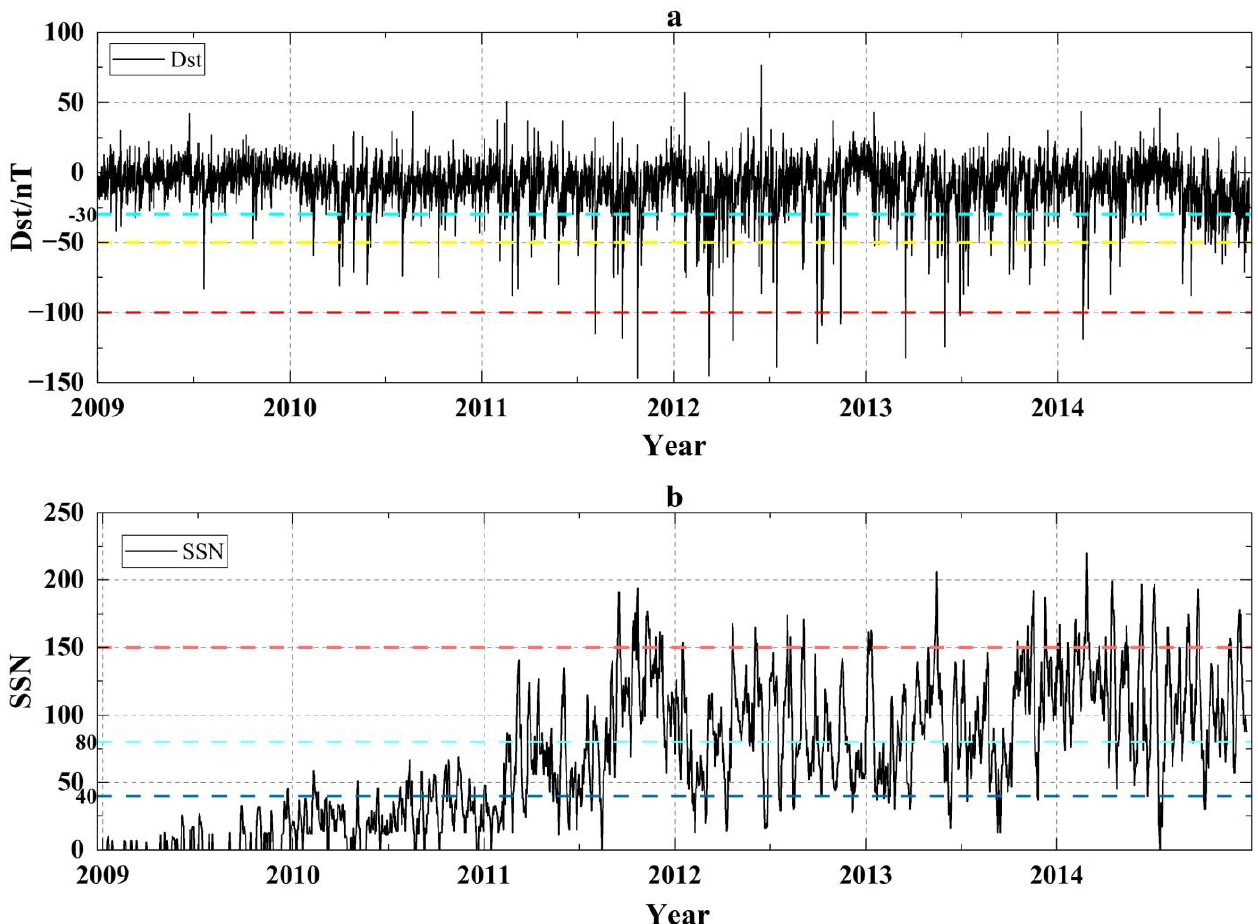
Figure 1. ( a ) Geomagnetic index and ( b ) solar activity index from 2009 to 2014. (In Figure 1a, colored dashed lines ( − 30, − 50, and − 100 nT) represent the boundary between Weak, Moderate, and Intense magnetic storms, respectively. In Figure 1b, colored dashed lines (40, 80, and 150) represent the boundary between Low, Moderate, and High solar activity, respectively.)